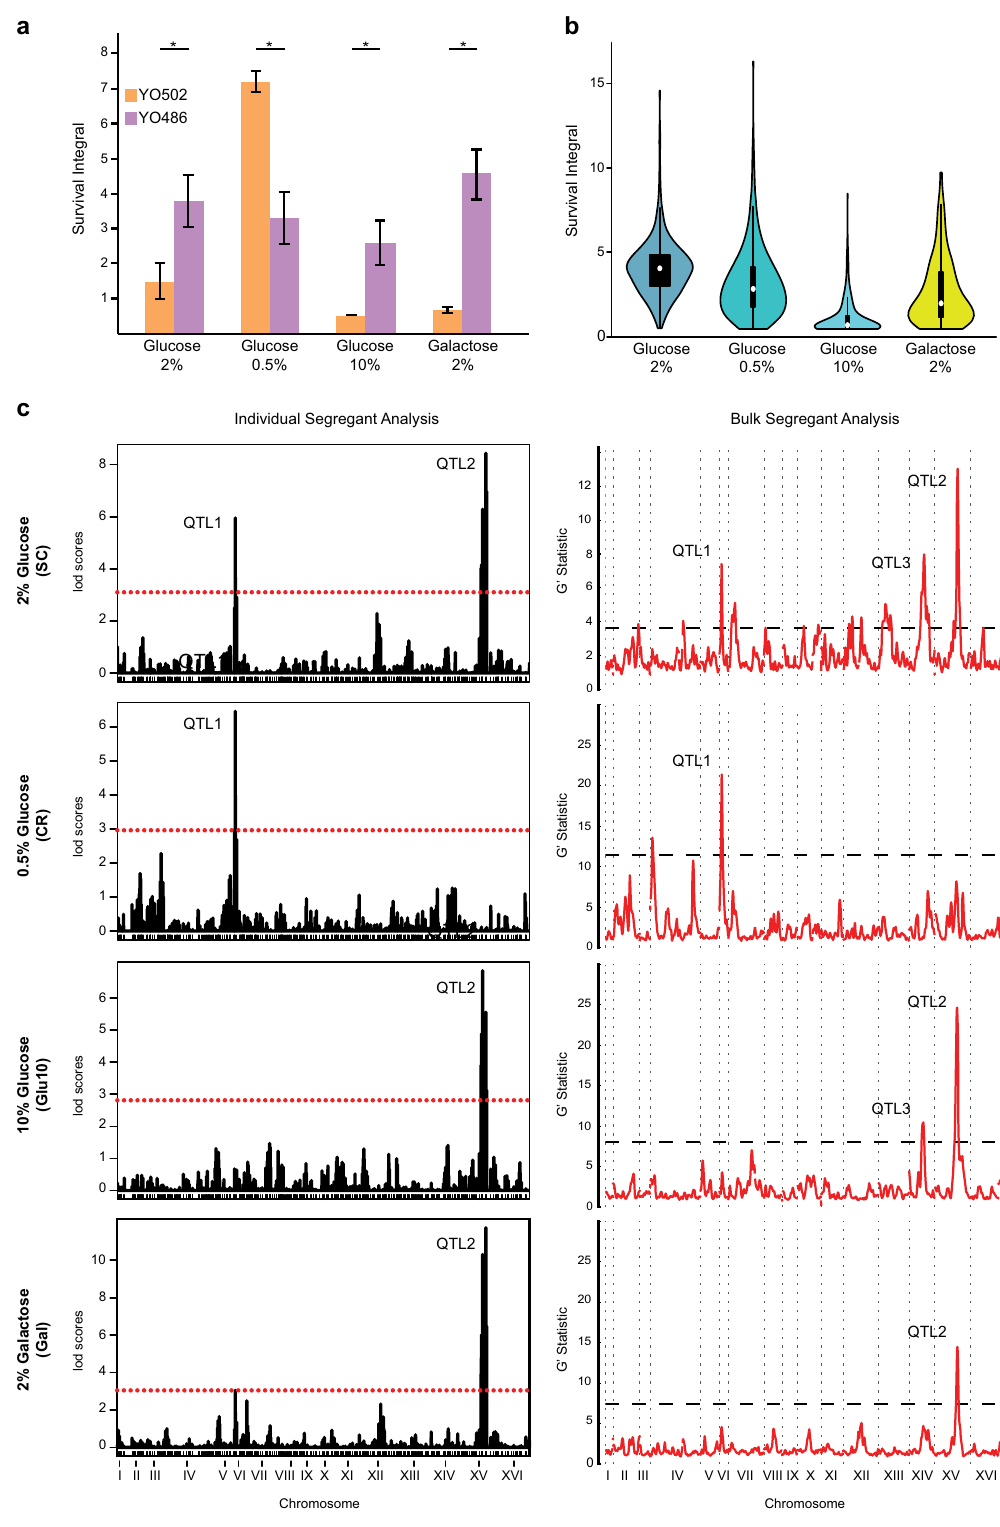
Fig. 2 CLS variation across the “ sake × tecc cross ” reveals different aging QTLs depending on growth conditions. a Comparison of SIs between the parental strains of the “ sake × tecc cross ” shows signi fi cant differences; Asterisk, signi fi cantly different by Student ’ s t -test, p -value < 0.05. Values are mean ± SDs. b Violin plot representation of survival integrals determined for the “ sake × tecc cross ” segregants in the indicated conditions. c QTL mapping using Individual Segregant Analysis (ISA, left column) and Bulk Segregant Analysis (BSA, right column) strategies for CLS data obtained when strains were aged in SC medium containing 2% glucose (SC), 0.5% glucose (CR), 10% glucose (Glu10), and 2% galactose (Gal). For ISA, the dotted red line represents signi fi cance thresholds corresponding to p -values of 0.05. The black dashed line in the BSA panels, indicating the G ′ statistic signi fi cance threshold, corresponds to a false discovery rate of